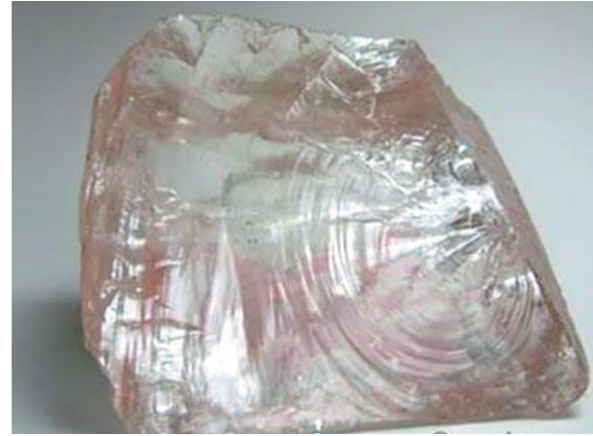
Fig. 11 Quartz: fracture surface (https://geology.com/minerals/ quartz.shtml).